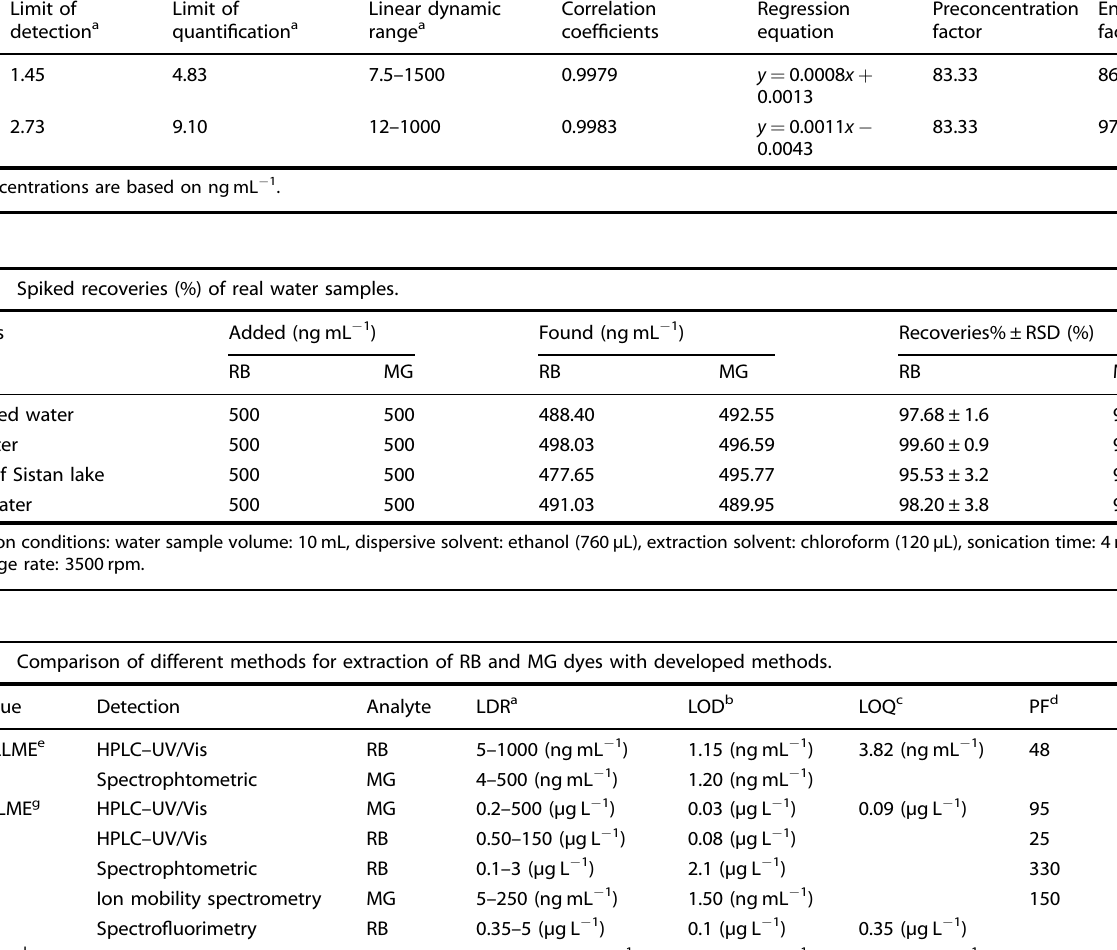
Table 1. Analytical characteristics of the developed method. Analyte Limit of detection a